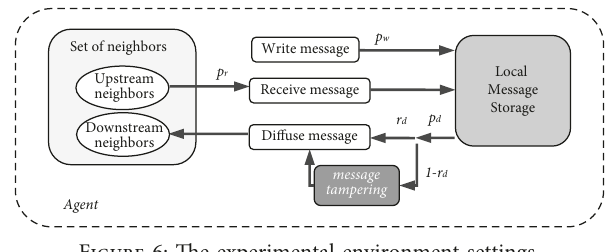
Figure 6: The experimental environment